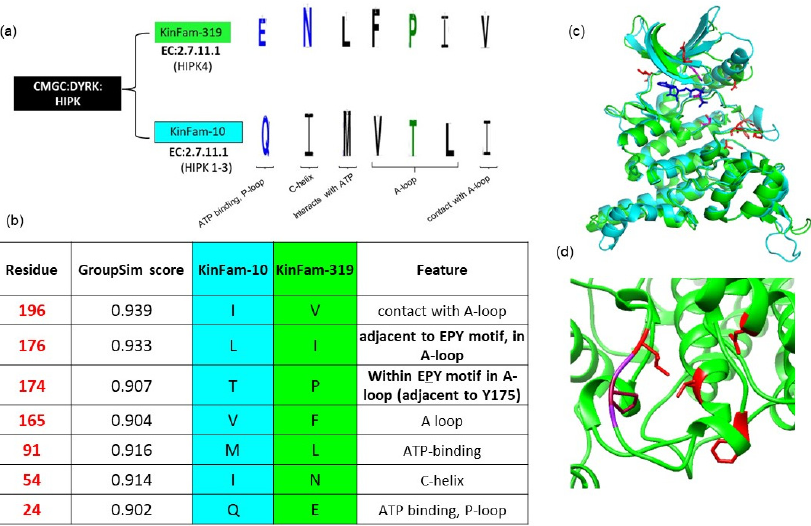
Figure 10. Specificity-determining positions (SDPs) predicted using CATH-KinFams: an example using the HIPK family. ( a ) HIPK family from KinBase is subdivided into two KinFams using CATH, each represents a distinct set of HIPK proteins ( b ) list of top-ranked SDPs (in red) that are specific to each KinFams-10 (HIPKs 1-3, cyan) and KinFam-319 (HIPK4, green). The majority of SDPs occur at and near the activation loop. SDPs (red) are numbered and mapped according to the AlphaFold2 af_Q8NE63_model. ( c ) Superposition of representative structures from KinFam-10 (PDB: 6P5S, green) and KInFam-319 (af_Q8NE63_model, HIPK4, cyan), respectively. Active site residues (K40, D136, D158) are shown in magenta; Ligand molecule (namely 3NG), which binds at the ATP binding site is shown in blue. ( d ) Close-up view of SDPs (in red) and their location within the ATP-binding site and activation loops. The activation loop of the DYRK family has a characteristic YxY element, whose sec- ond tyrosine is auto phosphorylated for kinase activation [55]. This motif is known to be altered to STY and EPY in HIPK1-3 and HIPK4, respectively. Interestingly, most of the SDPs are observed at and near this tyrosine-containing motif (See Figure 10). Addition- ally, E24Q substitution is observed in the P-loop lining the ATP-binding pocket, which also forms an interaction with an active site residue in the N-lobe. In summary, we iden- tified additional SDPs within the activation loop, which are likely to be associated with distinct functional phenotypes in the HIPKs and which can suggest further investigation using experimental studies.